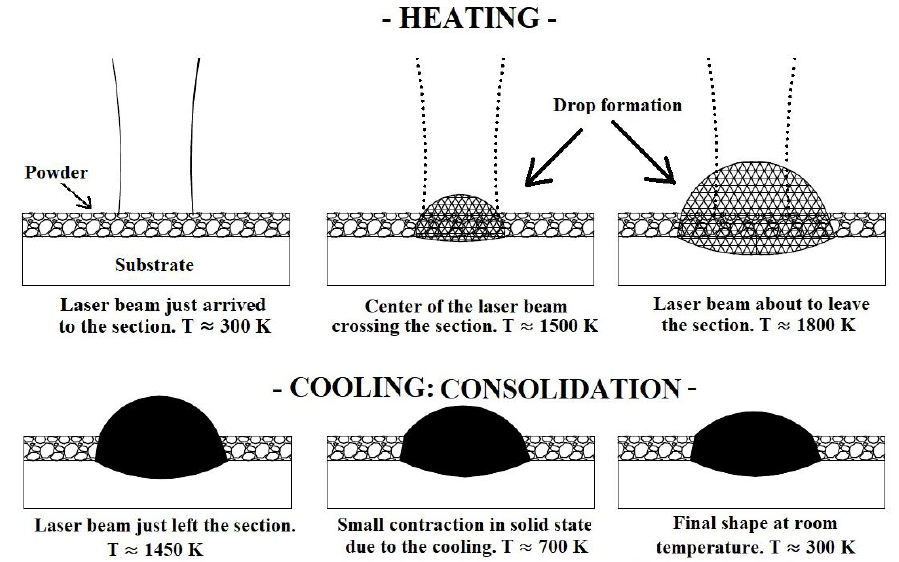
Figure 2. Illustrative representation of the consolidation of the material during the traversing of a given cross section by the laser beam.